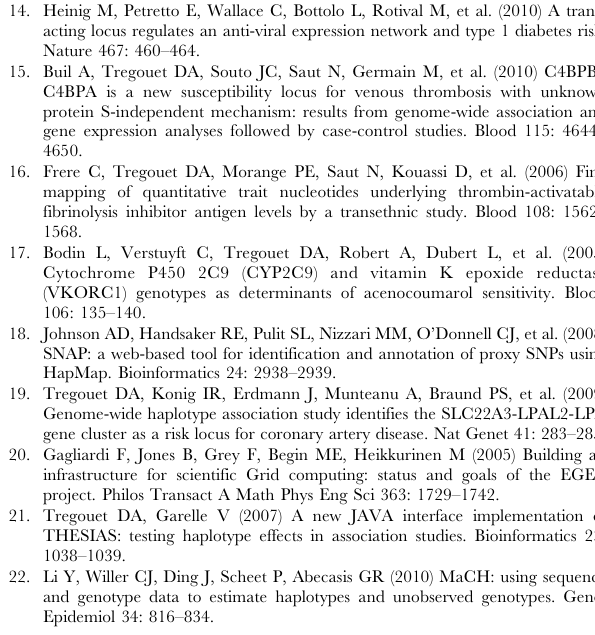
Table S2 List of probes with replicated multiple cis eSNP effects that map to disease-associated loci. Pairwise r 2 were derived from the SNAP software database [18]. Table S3 Known proxies for the identified htSNPs participating to cis haplotype effects. Proxies were identified by the SNAP software [18]. Table S4 List of probes that could not be assessed for replication in GHS and that map to disease-associated